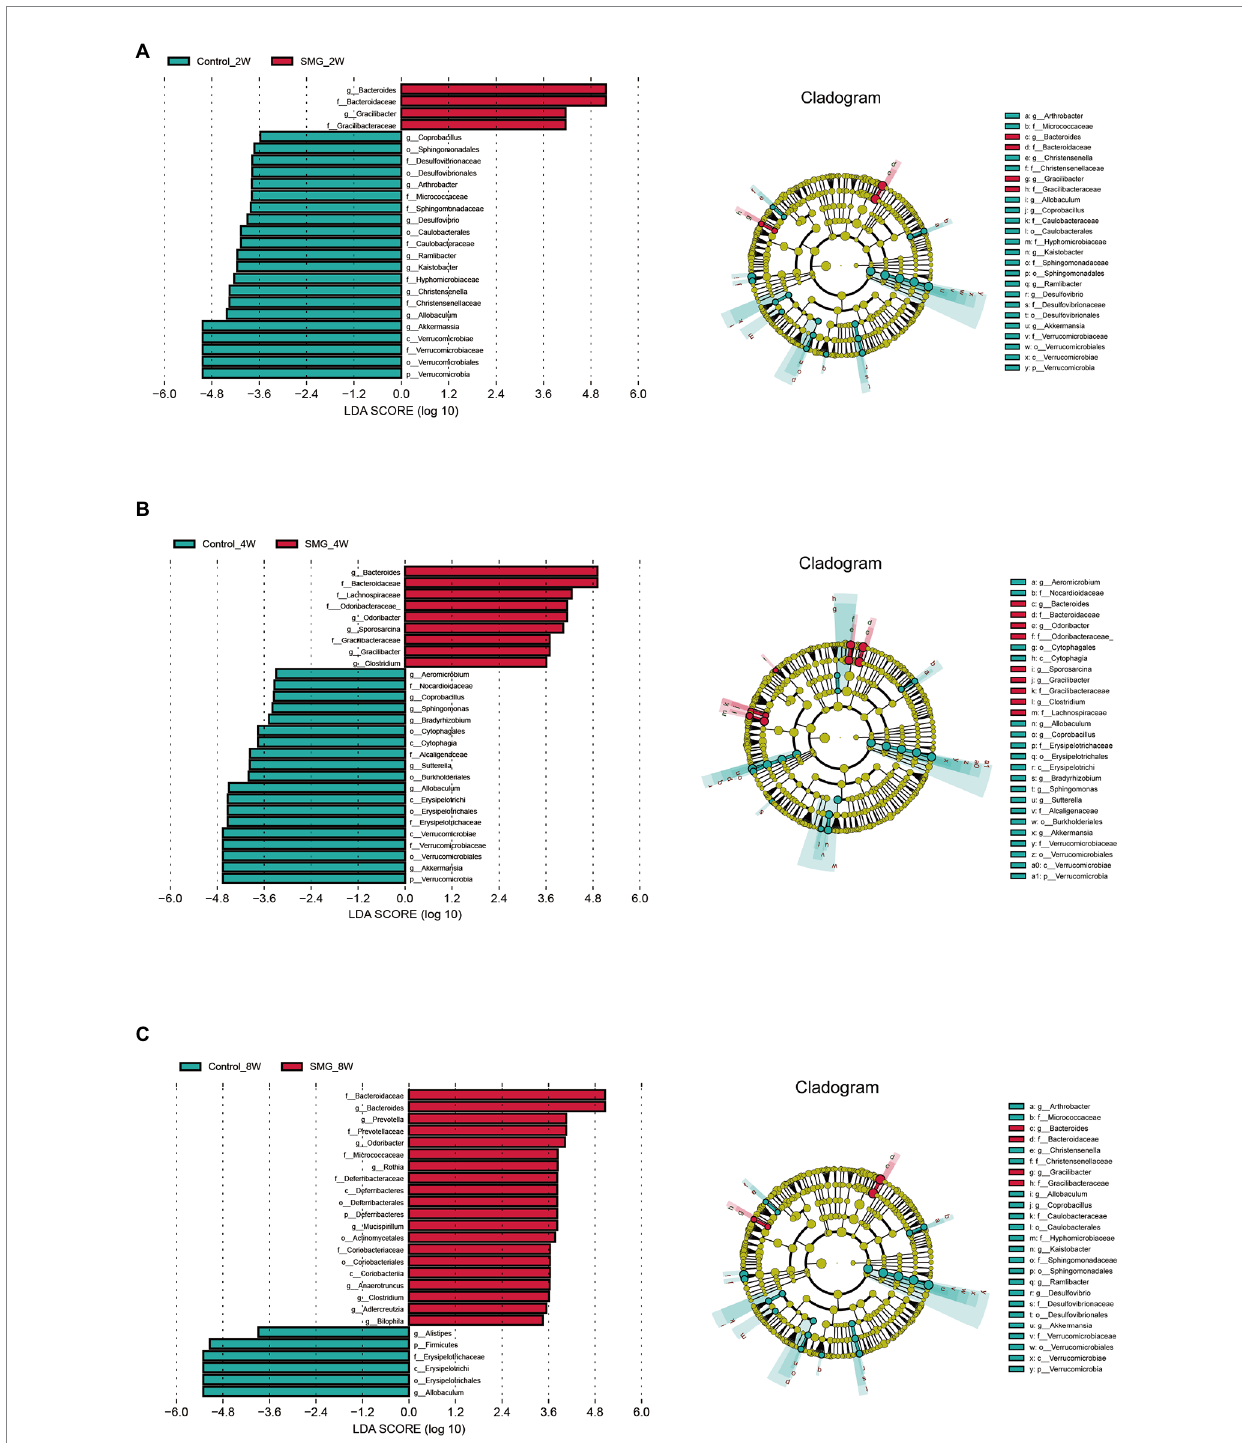
FIGURE 3 Microbial biomarkers associated with the SMG at week 2 (A) , 4 (B) , 8 (C) . Linear discriminant analysis (LDA) effect size (LEfSe) methods were used to identify the most deferentially abundant taxa between two groups at three time point. The cladogram of bacteria with larger effect size in the SMG group is shown in red, and bacteria with larger effect size in the control group are shown in